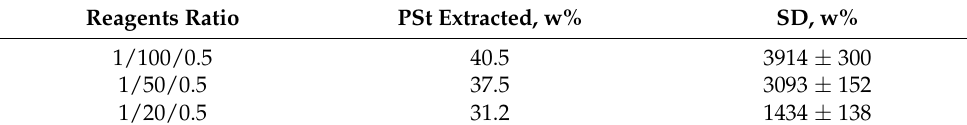
Table 4. SD changes depending on cellobiose-m/styrene/AIBN weight ratio.